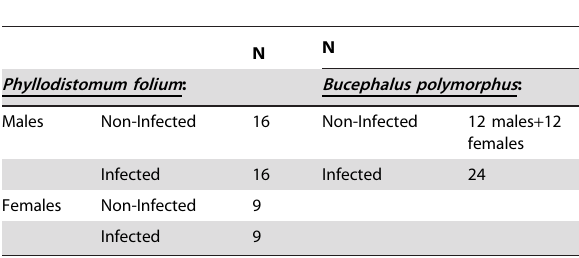
Table 1. Number of zebra mussels in each experimental group used for the analysis of biological response.